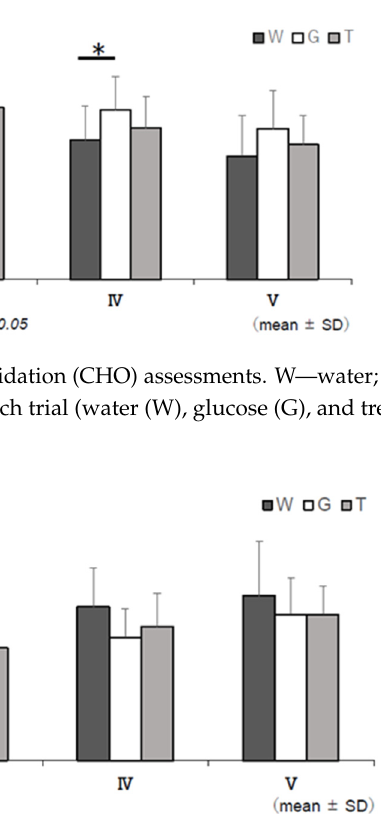
Figure 10. Energy expenditure (EE) assessments. W—water; G—glucose; T—trehalose. Comparison of mean EE (kcal/min) in each trial (water (W), glucose (G), trehalose (T)) in III–V ( n = 12).